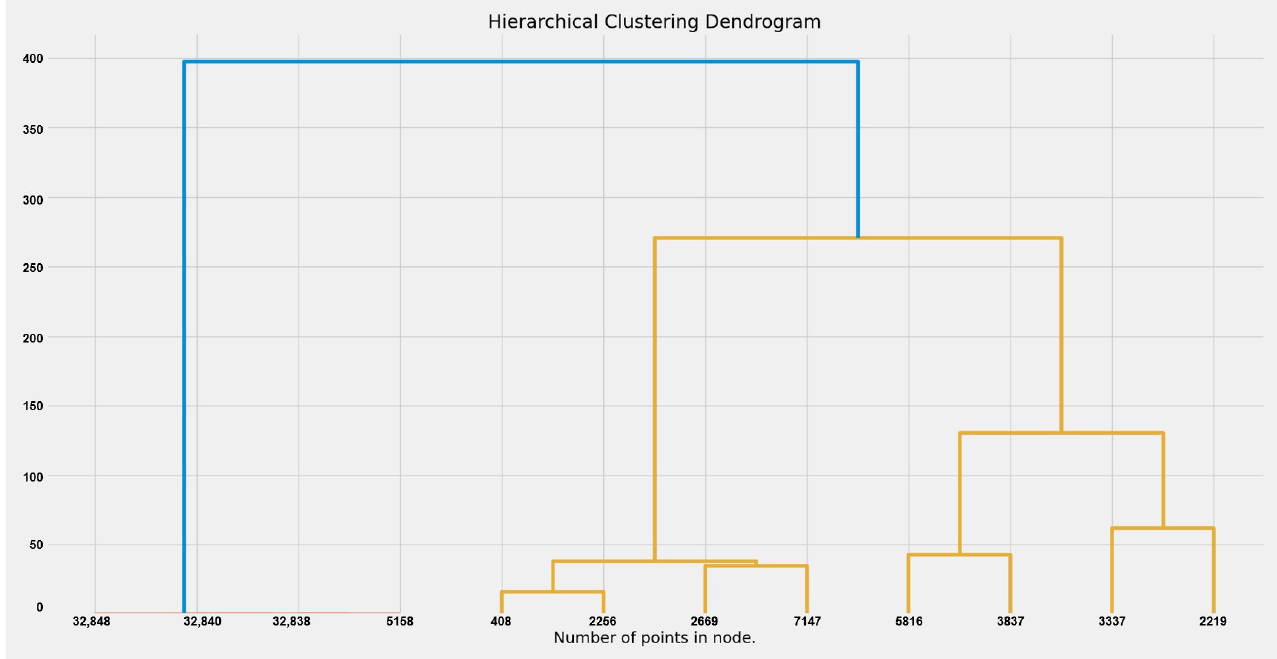
Figure 3. PCA transformation results.